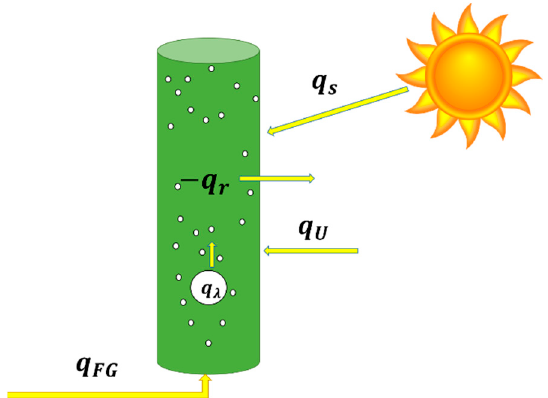
Figure 4. Visual representation of Equation (1), where, 𝑞 (cid:3045) is the heat inside the column, 𝑞 (cid:3022) is the heat transfer at the reactor wall, 𝑞 (cid:3007)(cid:3008) is the heat supplied to the reactor by the injected flue gas, 𝑞 (cid:3090) is the heat contribution from the latent heat of water as the gas phase composition changes before entering and after leaving the reactor, and q s is solar